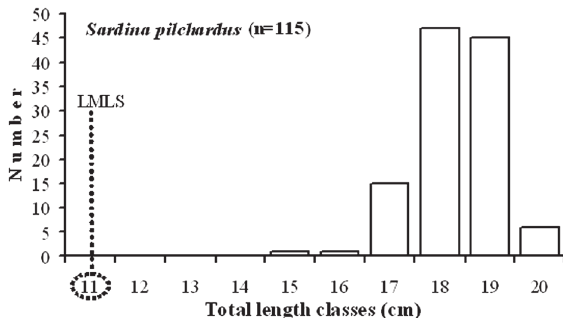
Fig . 12. – length frequency distribution of the fish trawl target spe- cies Sardina pilchardus (European pilchard) (lMls=legal Mini- mum landing